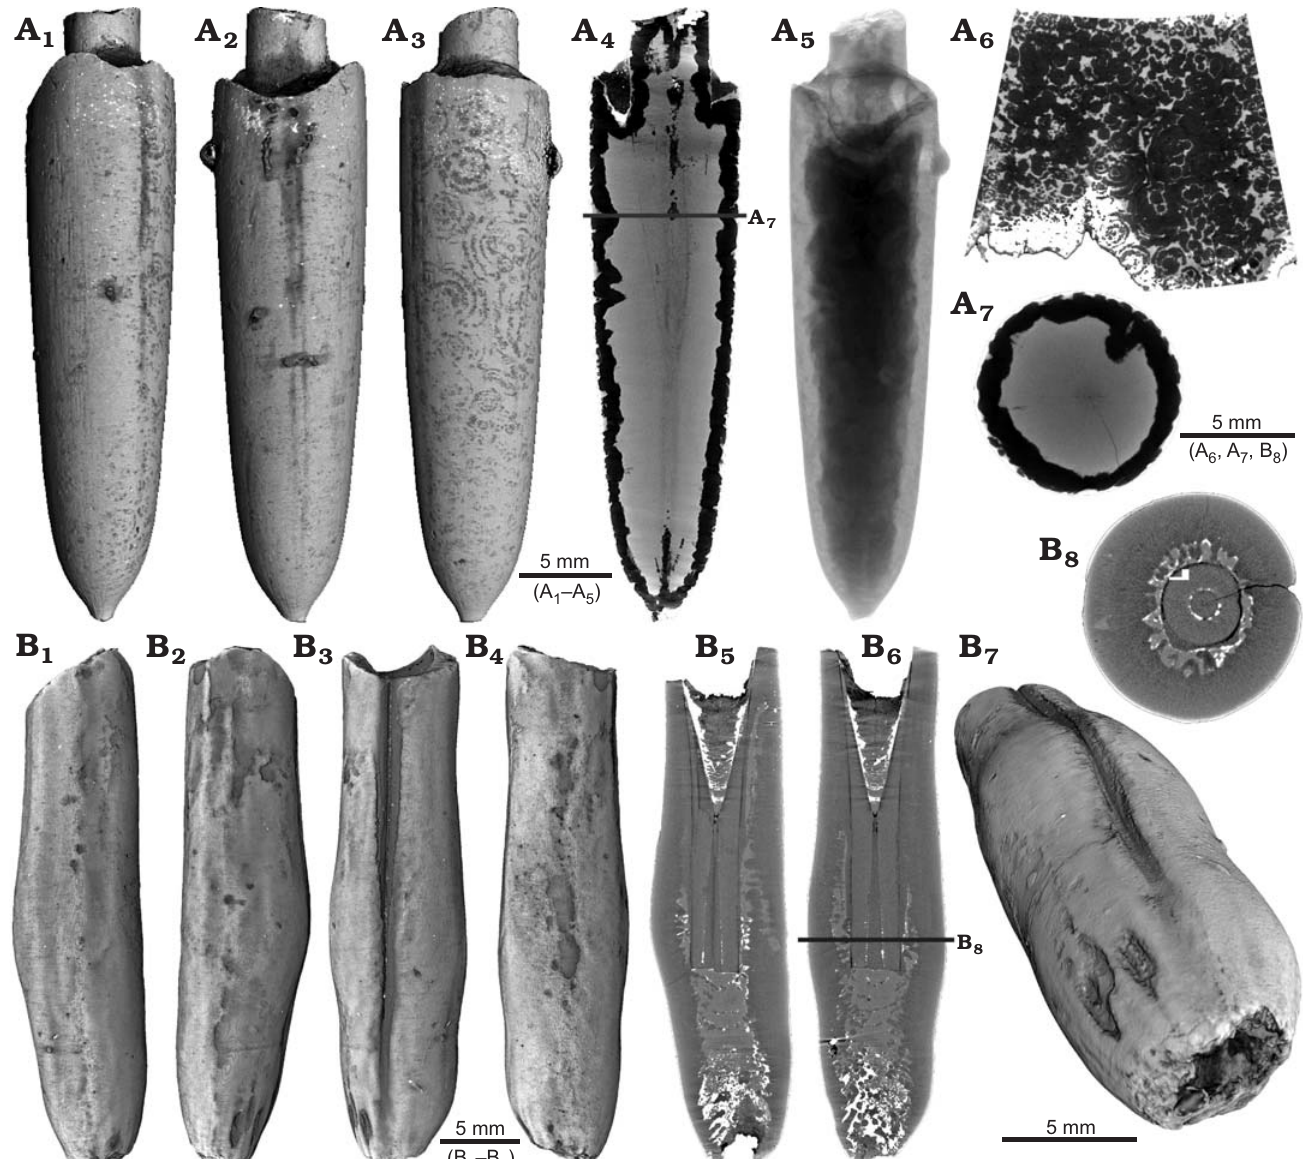
Fig. 5. A . Rostrum of belemnite Gonioteuthis sp., RUB-Pal 11301, Campanian, Höver (NW-Germany) with forma aegra clavata (coll. L.